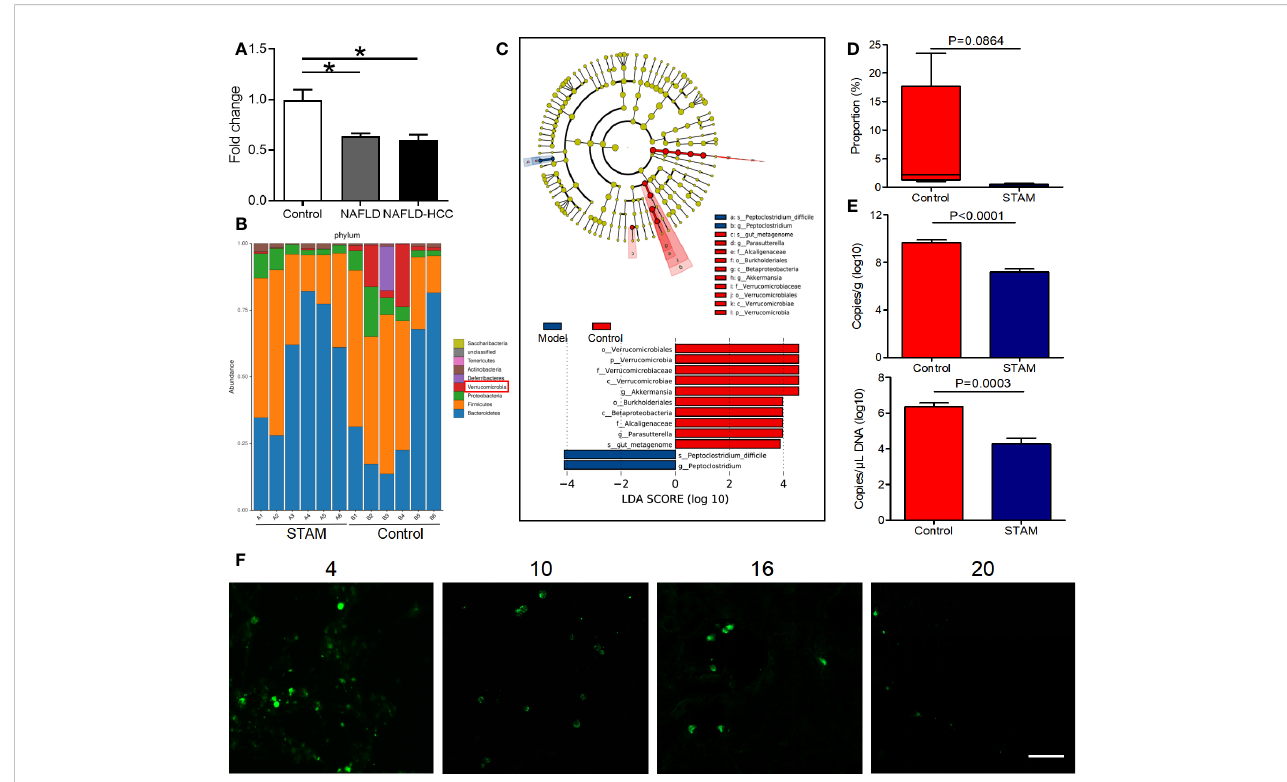
FIGURE 1 The intestinal abundance of A muciniphila was decreased in patients and mice with NAFLD-HCC (STAM at 20 weeks) (A) The relative abundance of A muciniphila in patients with NAFLD or NAFLD-HCC and healthy controls by qPCR (n=6). *P<0.05 by unpaired Student ’ s t test. (B) Comparison of the faecal microbiota between STAM at 20 weeks and controls at the species level by 16S rRNA sequencing. (C) LEfSe analysis of the faecal microbiota between the STAM at 20 weeks and healthy controls. Cladogram displays the taxonomic tree of differentially abundant taxa. Histogram represents the LDA scores of bacteria with signi fi cant differential abundance between the compared groups, identi fi ed by different colors. (D) The proportion of Akkermansia in the faecal microbiota was compared. (E) qPCR validation of the abundance of A muciniphila in STAM at 20 weeks and control. (F) FISH detection of A muciniphila on the surface of the colon from STAM mice at 4, 10, 16, 20 weeks of age. Data are presented as the mean ± SEM and were analysed by unpaired Student ’ s t test. NAFLD, non-alcoholic fatty liver disease; HCC, hepatocellular carcinoma; STAM, streptozotocin+high fat diet- treated